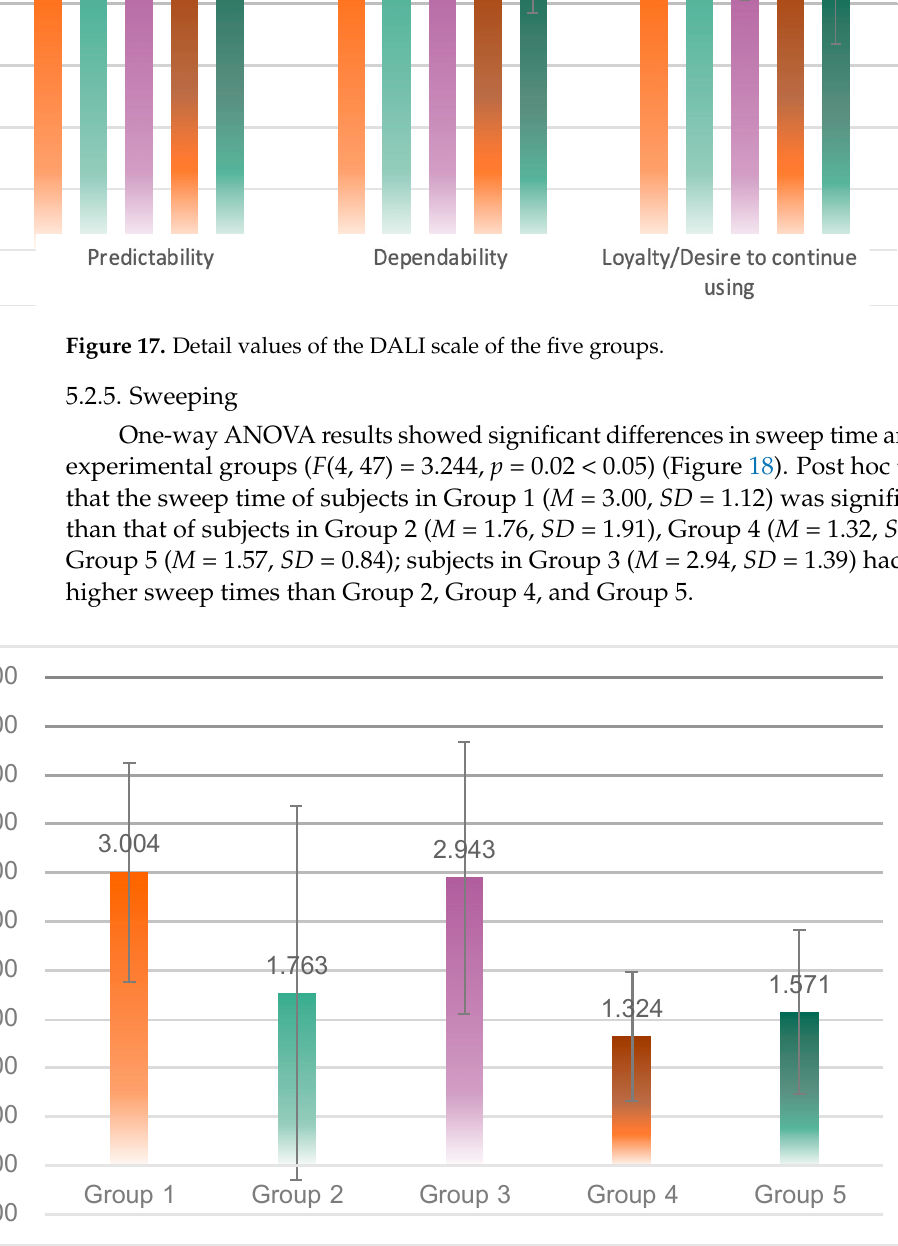
Figure 16. Average value of trust score of the five groups.